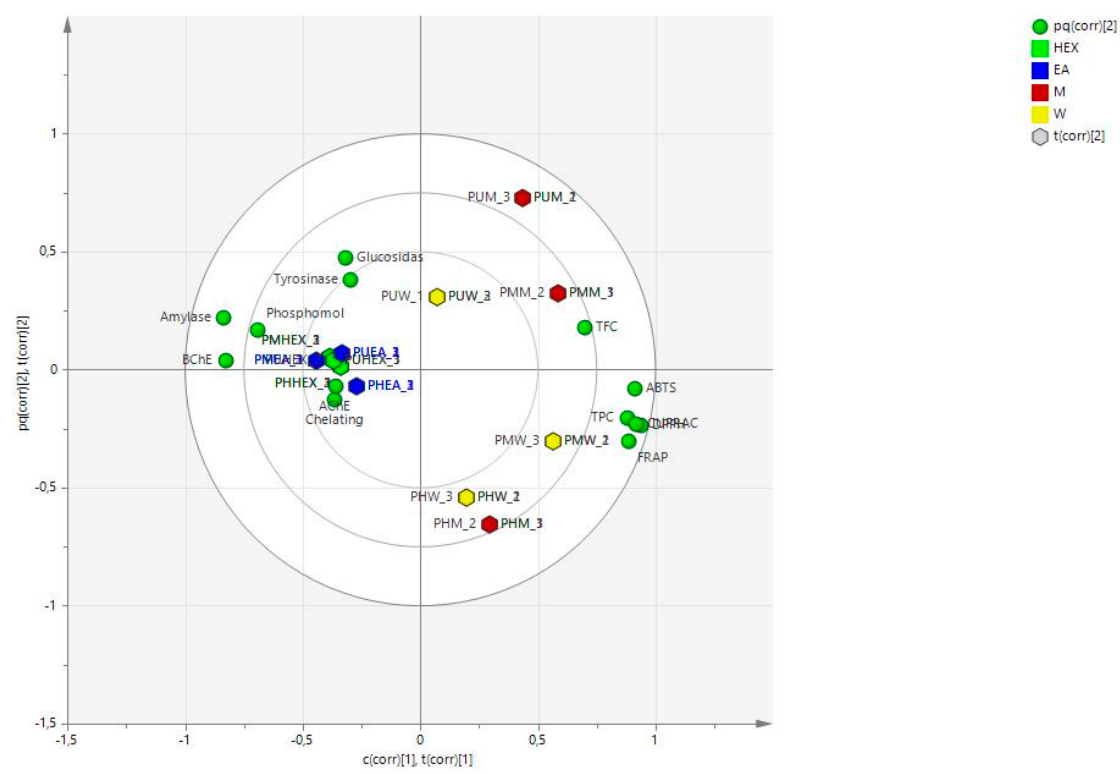
Figure 5. Biplot summarising the results of the assays and the different extracts.